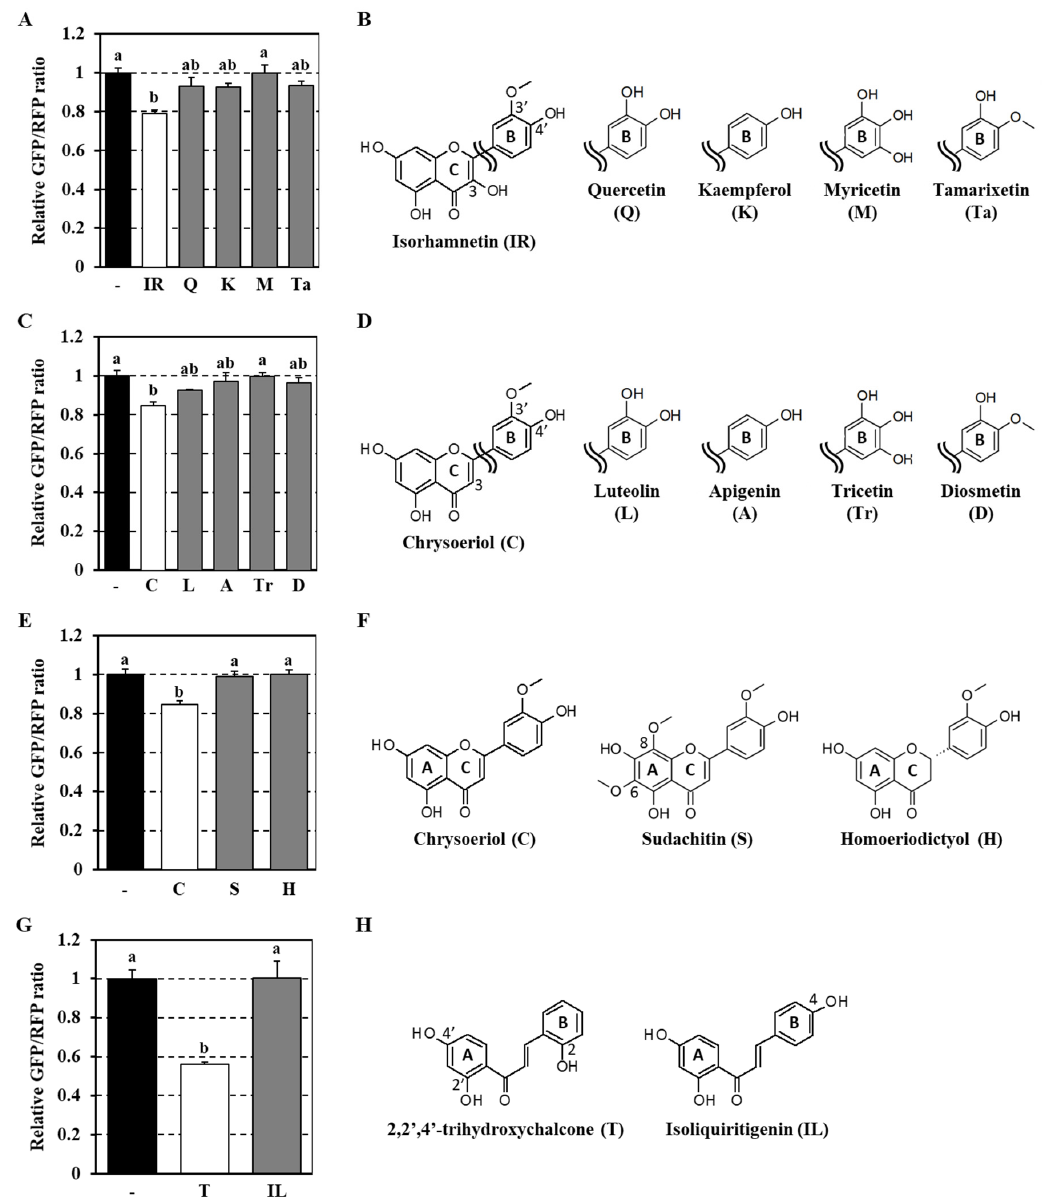
Figure 4. Structure–activity relationships of flavonoids as regulators of the autophagy flux. Co-cultured transgenic and wild-type HeLa cells were treated with each flavonoid (10 µ M) for 12 h ( A , C , E , G ). The cells were then visualized using an Operetta high-content imaging system at 40 × magnification to obtain GFP / RFP ratios. Data represent the mean ± SEM of triplicate measurements. Di ff erent letters indicate significant di ff erences, as assessed by the Tukey–Kramer test ( p < 0.05). The chemical structures of the tested phytochemicals are shown ( B , D , F , H